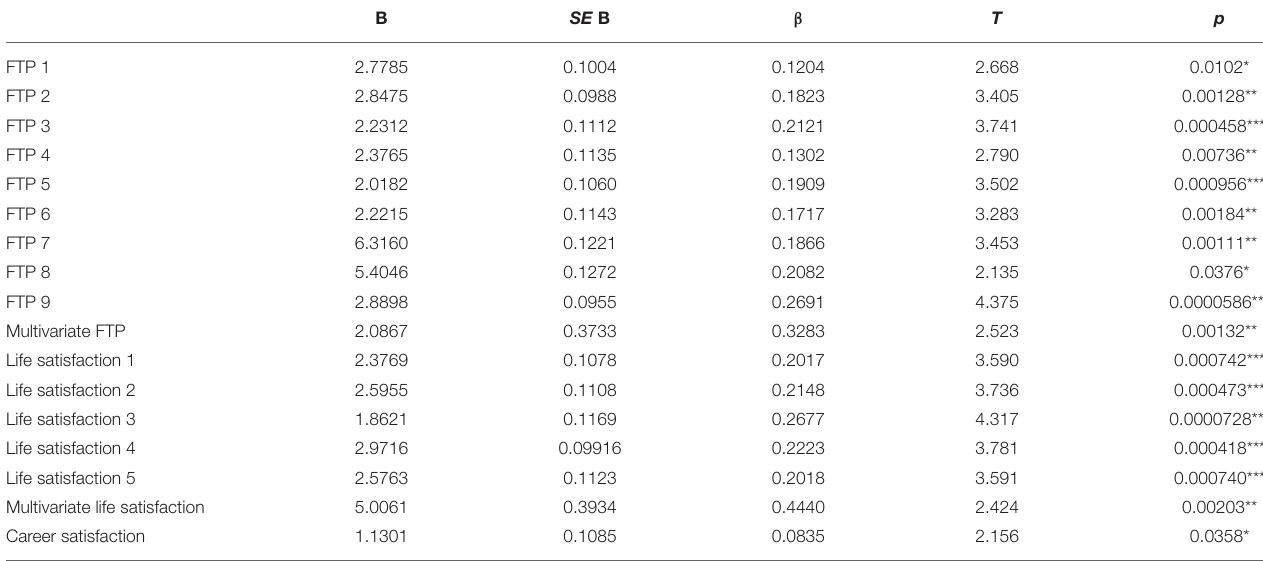
TABLE 6 | Logistic regression between responses to the statement “I have an idea of what I will be doing musically one month from now” and measures of future time perspective (FTP), life satisfaction, and career satisfaction.